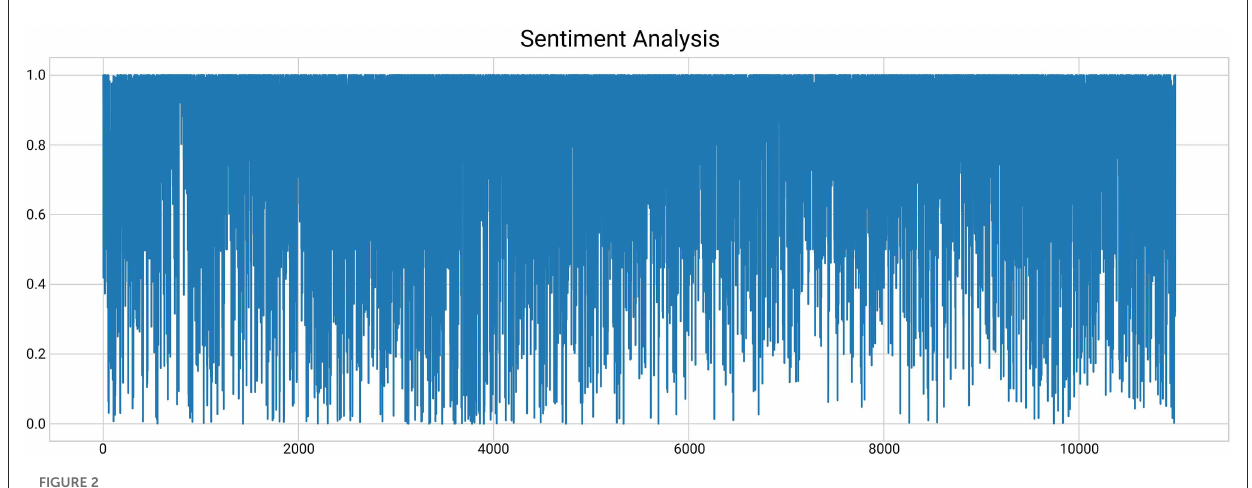
FIGURE2 Sentiment scores for the QQ music